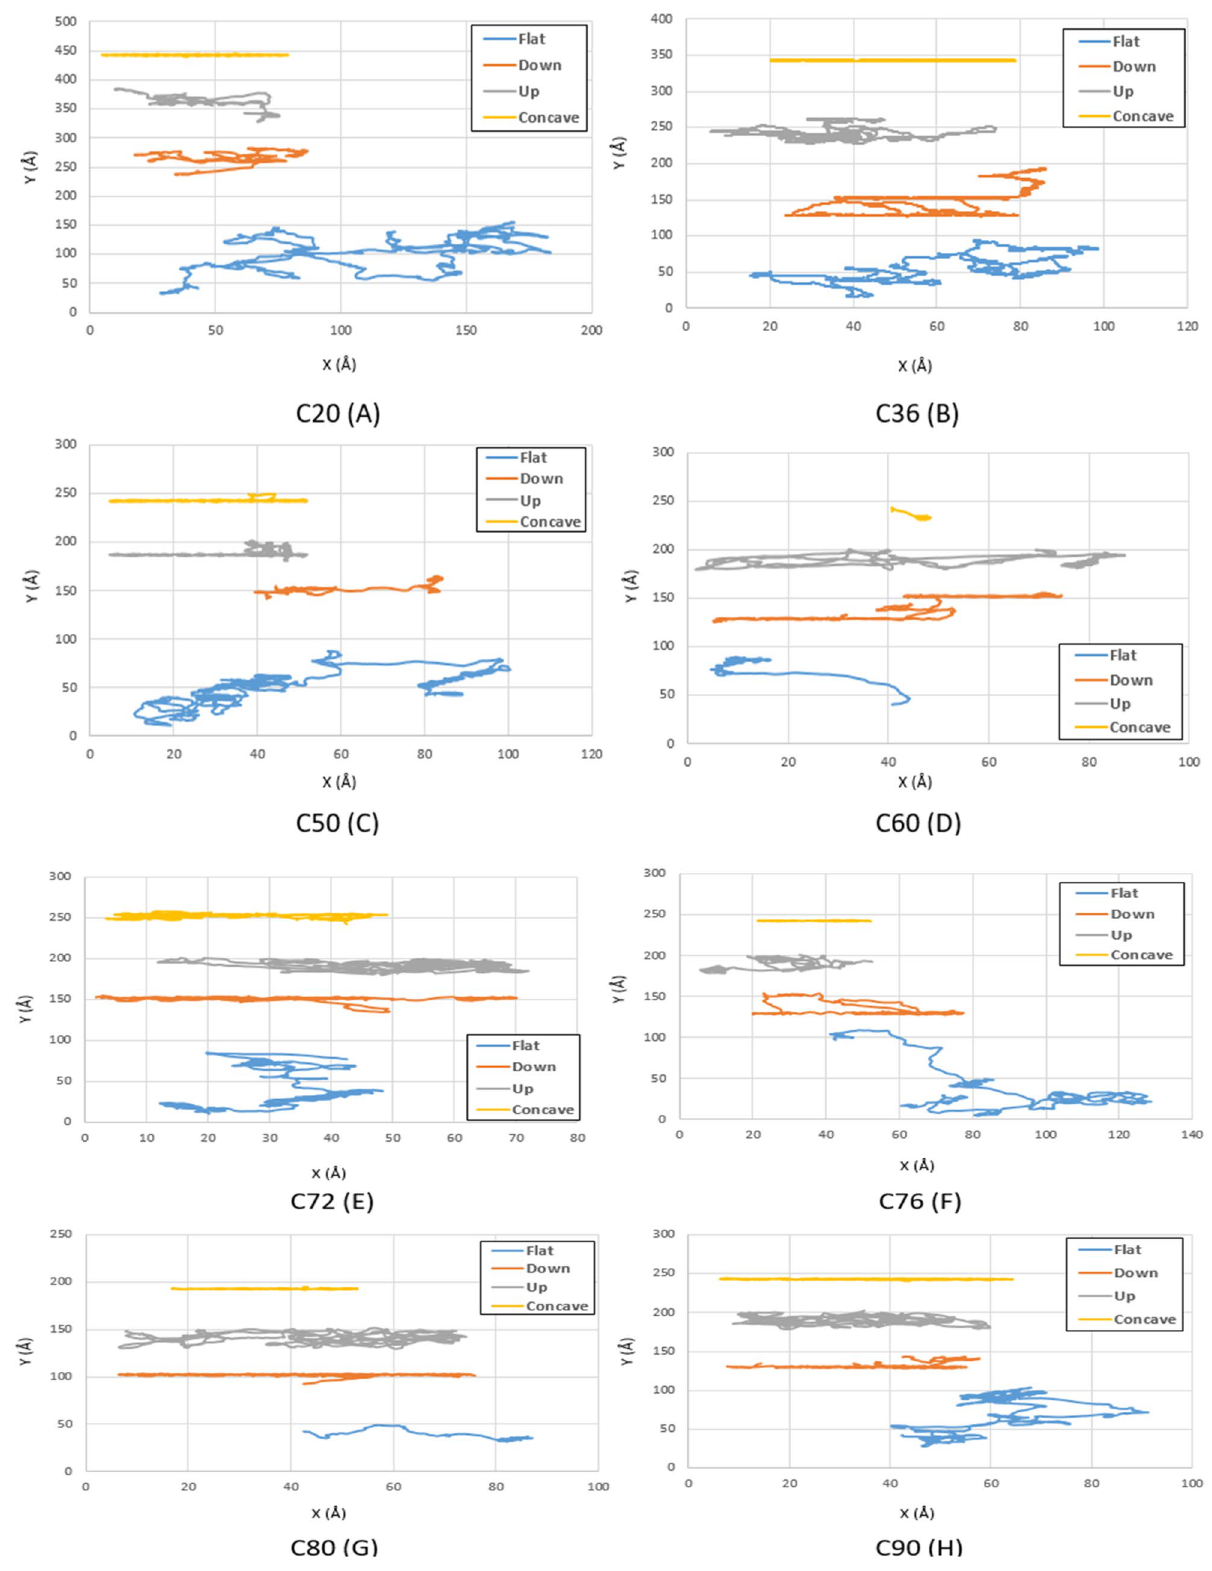
Figure 8. Trajectories of different fullerenes on a gold substrate at 600K for C 20 ( A ), C 36 ( B ), C 50 ( C ), C 60 ( D ), C 72 ( E ), C 76 ( F ), C 80 ( G ), and C 90 ( H ). The blue, red, black, and yellow lines show the trajectories of the molecules on the flat, down side of the step, top side of the step, and concave substrates,